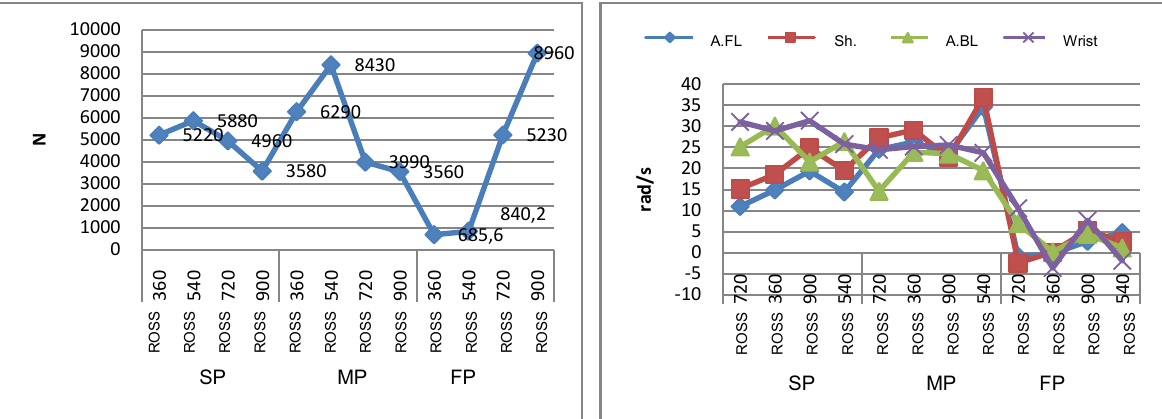
Fig.2. Comparative indicators of resulting GMC force, angle speed of body links of 12-14 years old female gymnasts in dismounts from BB of somersault from RO type.